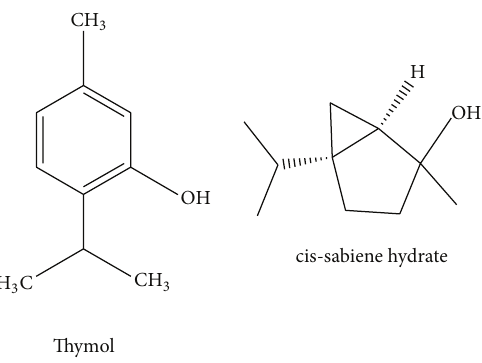
Figure 1: The formulas of marjoram extract main